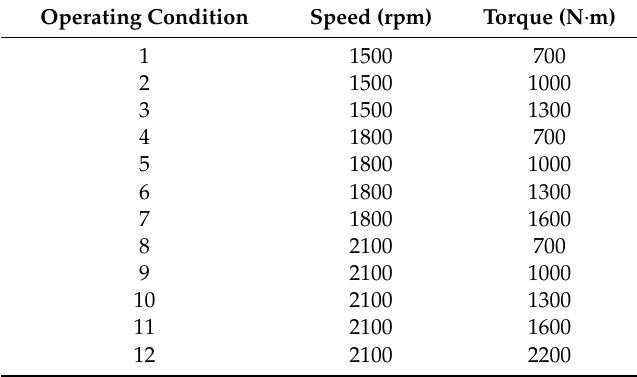
Table 3. The detailed operating conditions in the